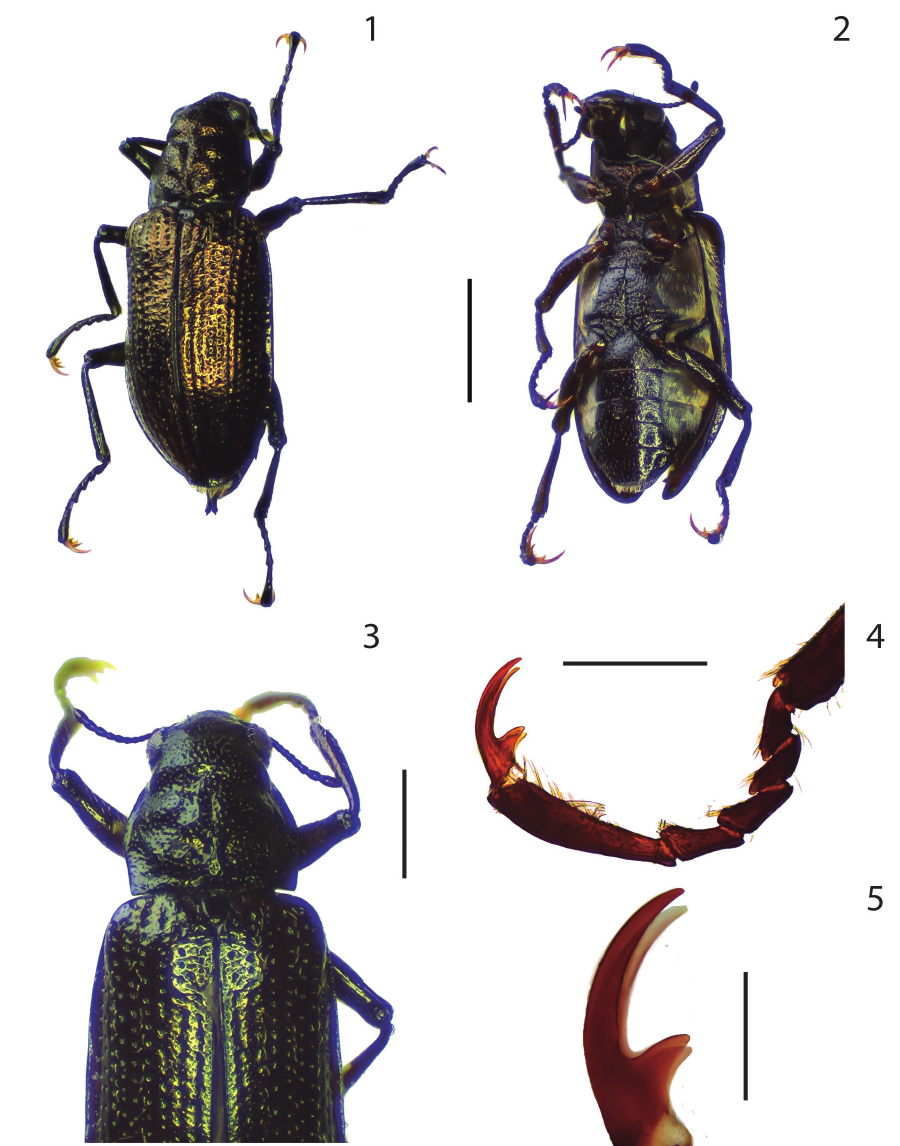
of eyes. Clypeus sculptured as head, frontoclypeal suture straight; labrum subrectangular, with anterolateral angles rounded and anterior margin slightly convex, punctuation similar to that of head, with rows of long golden setae on anterior and lateral margins of ventral region that exceed the limits of the labrum. Antennae